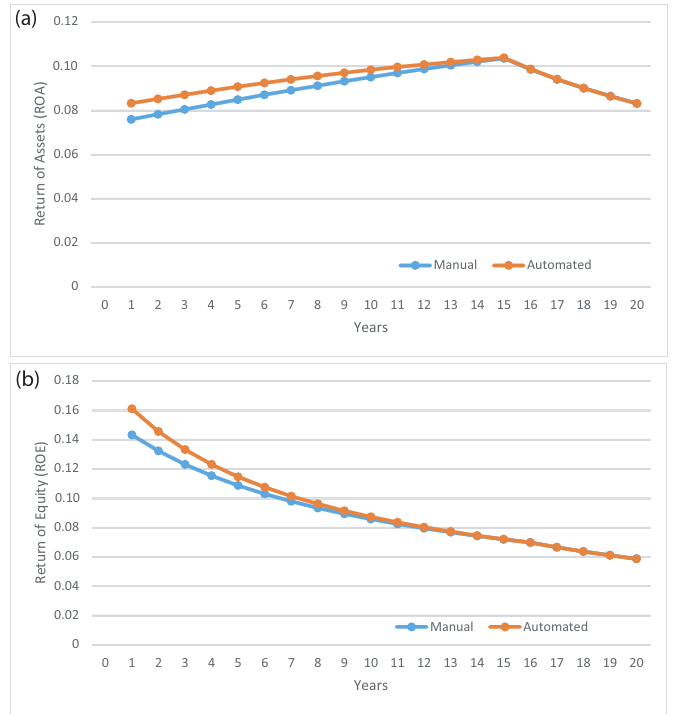
Figure 17. Comparative economic ratios for manual and automate maneuvers: ( a ) return of assets (ROA), and ( b ) return of equity